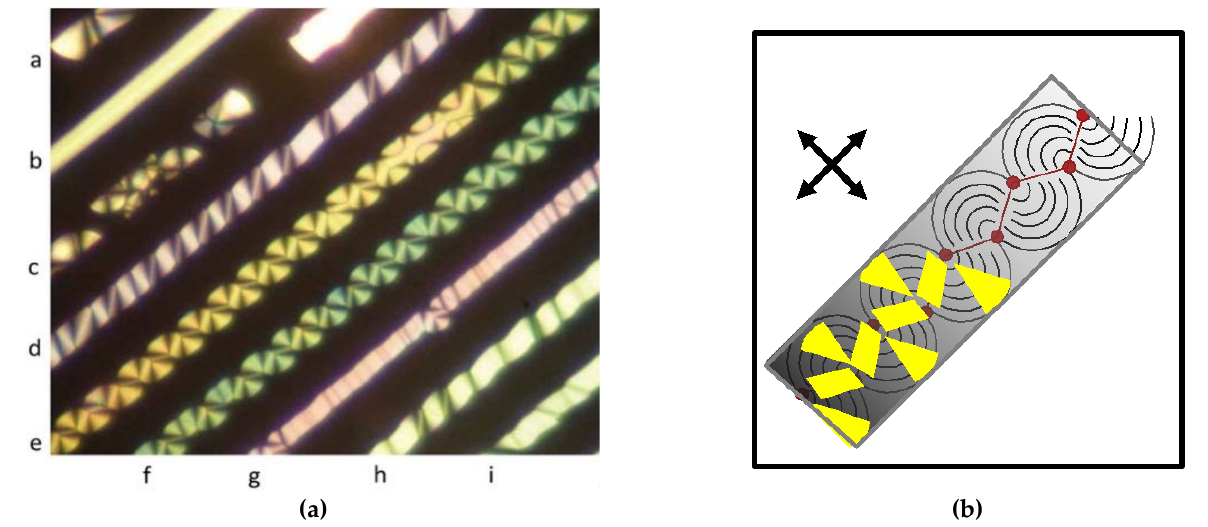
Figure 10. Taken from Bramble et al. [21], photographed at 150° in reflection mode, between crossed polars. ( a ) Stripes of a columnar Col h mesophase spontaneously aligned on a patterned silicon substrate with alternate 25 µ m-wide bands of a wetting and non-wetting surface. ( b ) An analysis of the director field of the egg and dart patterns in stripes e and f, in terms of the developable domain. The red lines joining them indicate the domain boundaries.